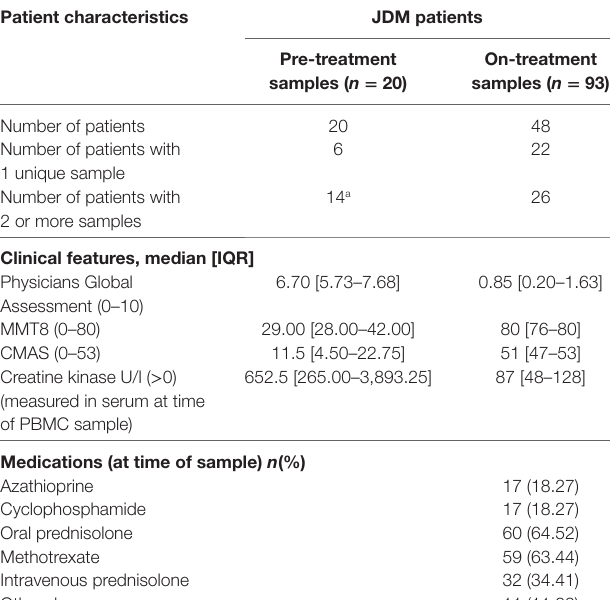
TaBle 2 | Demographic, clinical, and serological features of the JDM